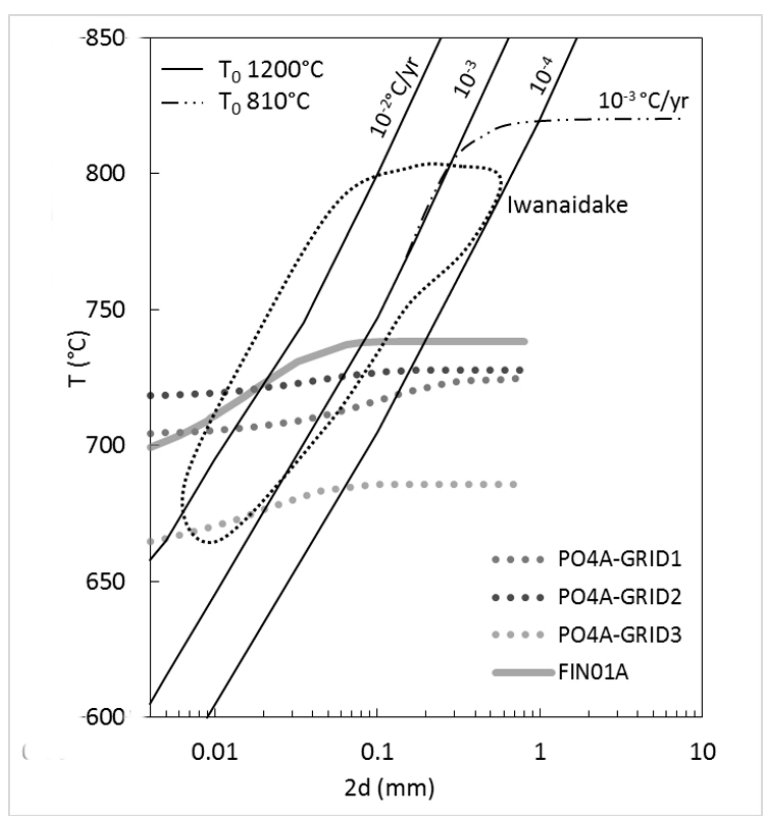
Figure 6. T (°C) vs. 2D plot of Finero diffusion curves. Temperatures are calculated according to Fabriès [3], constant cooling rate curves and Iwanaidake peridotite field are from Ozawa [9]. T 0 : initial temperature for the calculation of constant cooling rate curves.